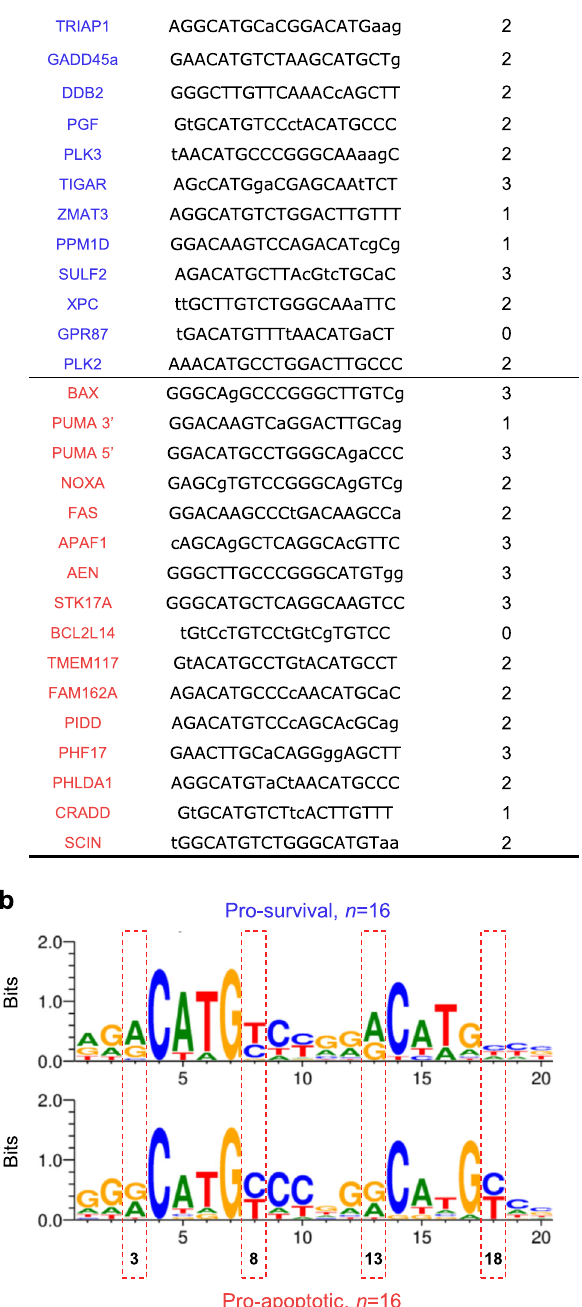
Fig. 2 G/C vs. A/T bp content at positions 3, 8, 13, and 18 distinguishes REs linked to distinct p53-driven cell fates. a The list of sixteen pro- apoptotic p53 REs (bottom) and 16 previously con fi rmed REs corresponding to genes driving p53-dependent pro-survival response (top) 19 , with their nucleotide sequence. Lower-case letters in RE sequences indicate mismatches from p53 RE consensus. The last column shows the number of G/C bps at positions 3, 8, 13, and 18, emphasizing a tendency of pro- apoptotic REs having ≥ 2, and pro-survival REs having ≤ 2. b Motif analysis of pro-survival (top) and pro-apoptotic (bottom) REs listed in a . Positional analysis con fi rms an increased frequency of G/C bps at the core sequence- adjacent positions among pro-apoptotic REs and A/T bps among pro- survival REs. Source data are provided as a Source Data fi